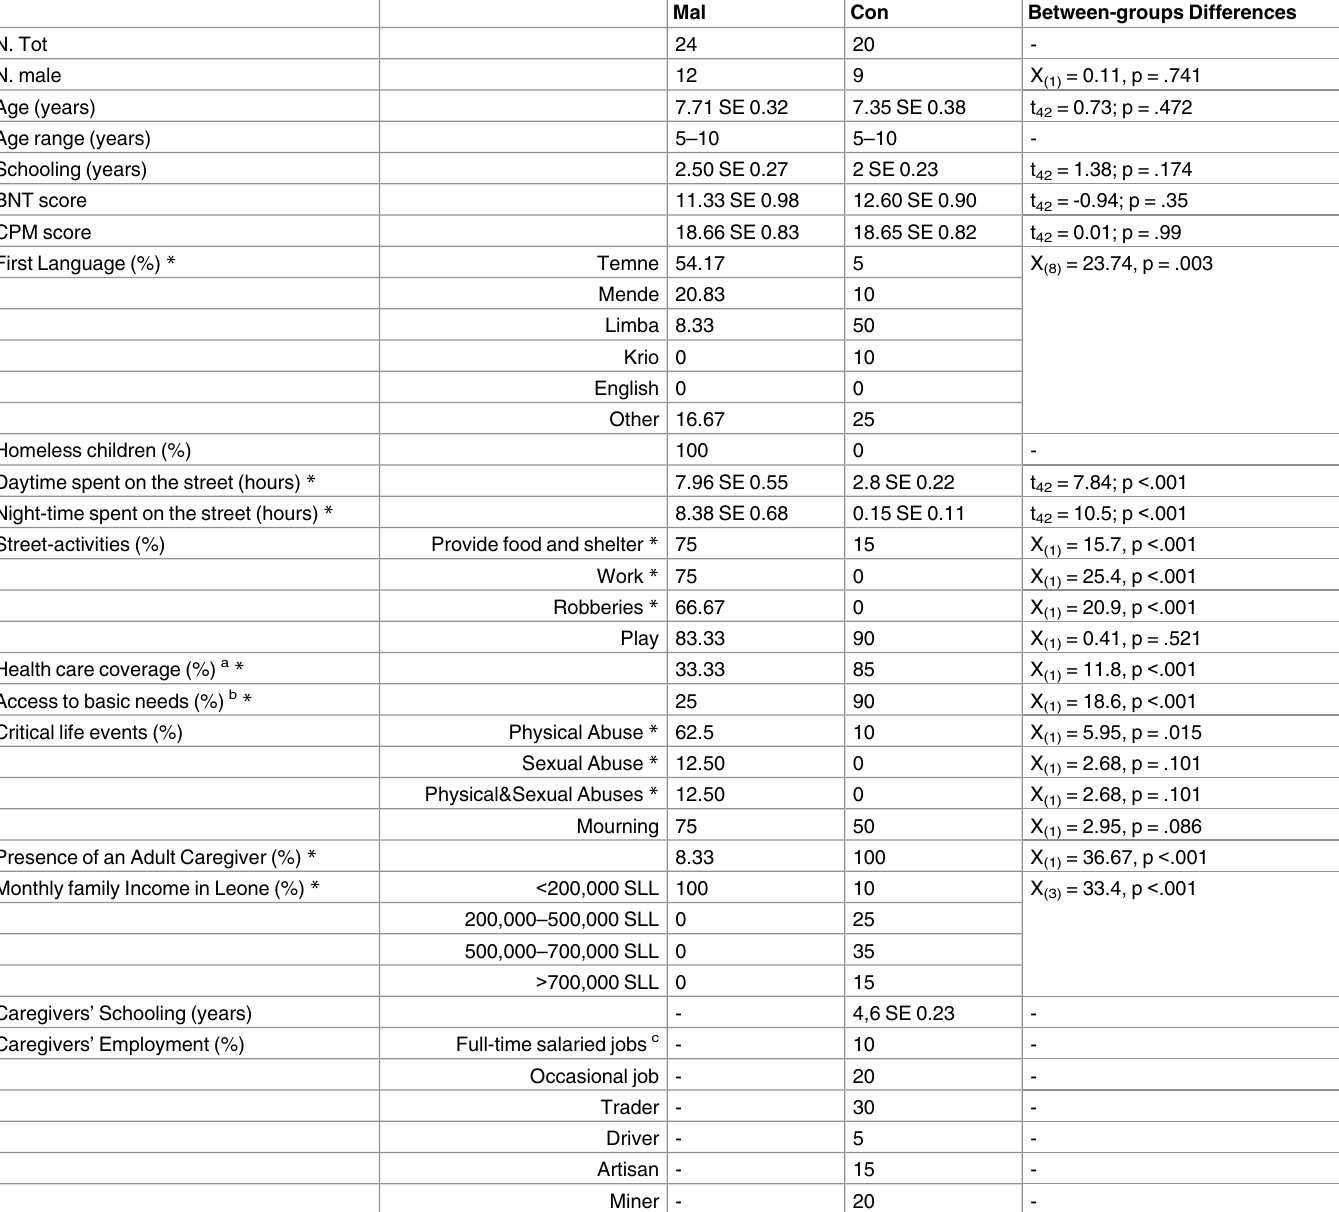
Table 1. Socio-demographic description of the samples.